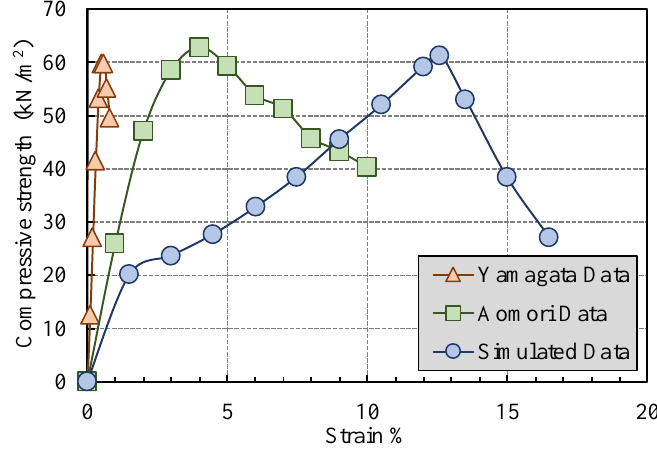
Figure 6. CAE-MPS simulation results compared to known data.